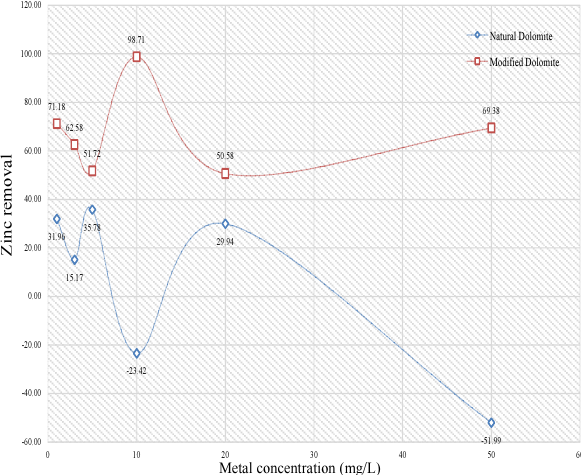
Fig. 12. Comparison of the removal percentage of zinc from the solution for certain concentrations using 0.1 g of natural and modified dolomite within a 60 minute contact time